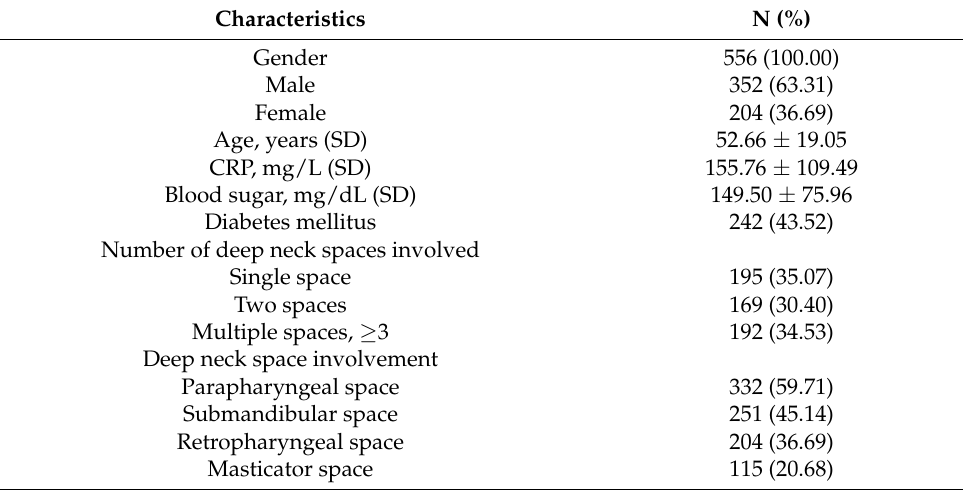
Table 1. Clinical characteristics of the 556 patients with